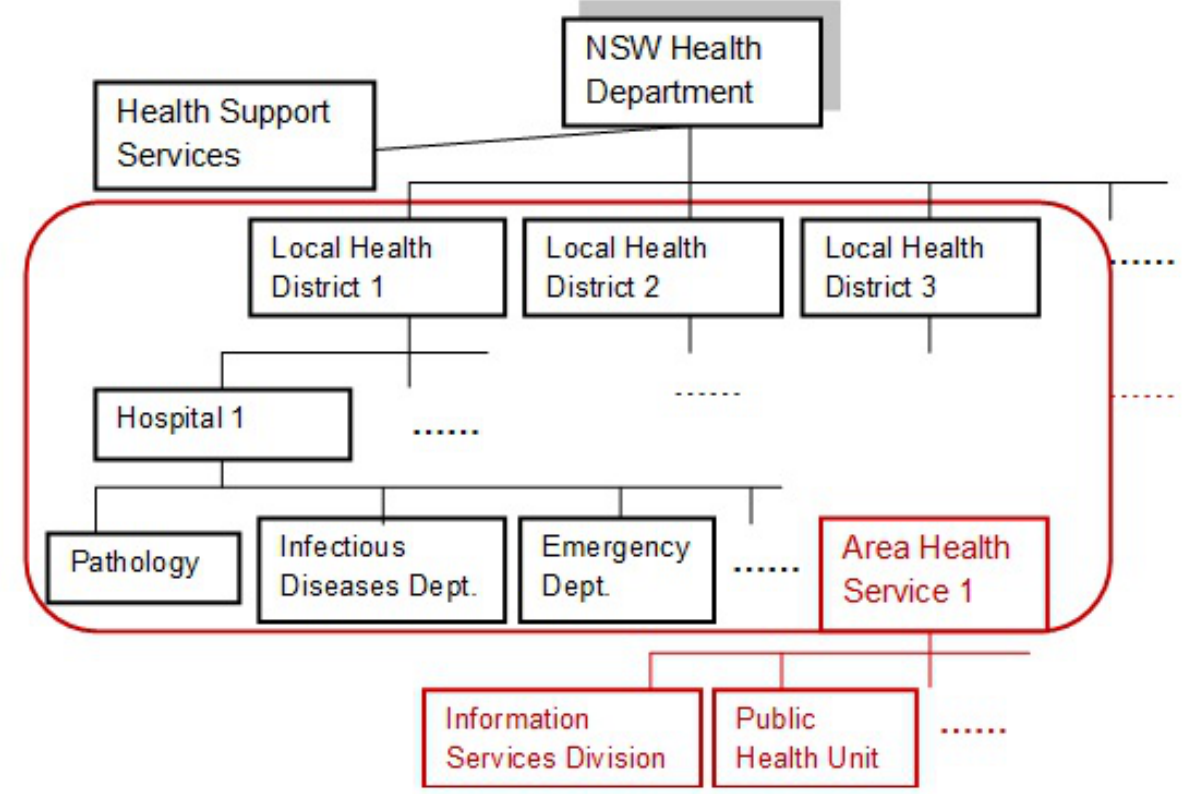
Figure 1. NSW Ministry of Health structure in